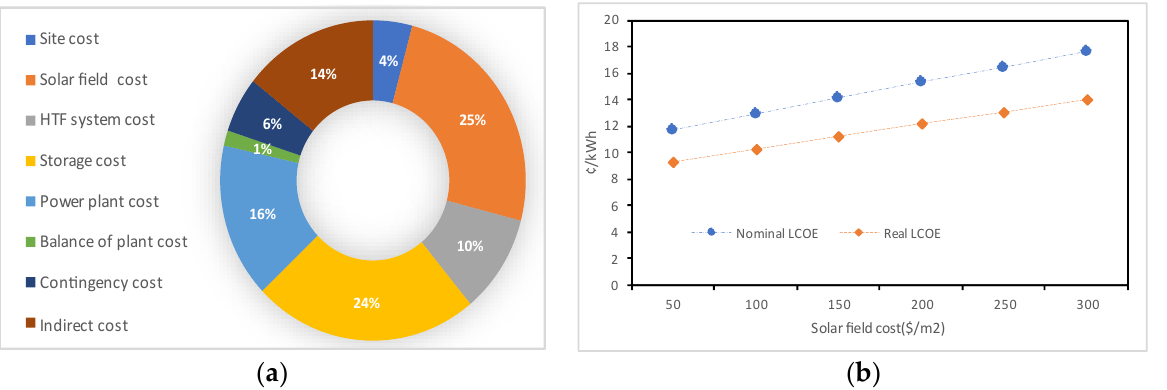
Figure 10. ( a ) Breakdown of the total investment cost. ( b ) Sensitivity of LCOEs towards solar field cost.